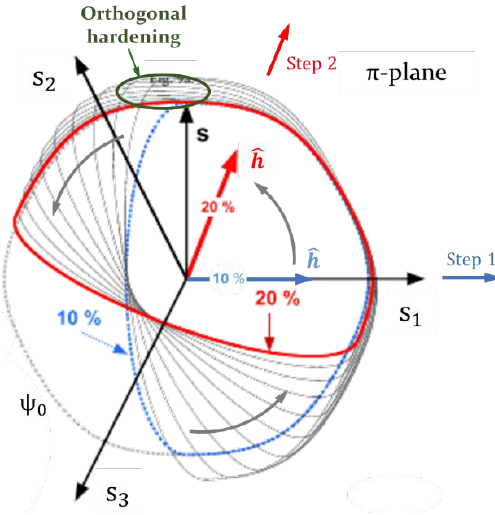
Figure 12. HAH 14 model’s description of orthogonal hardening in a two-step loading process. Reprinted with permission from Ref. [66]. 2013, Barlat, F. et al.